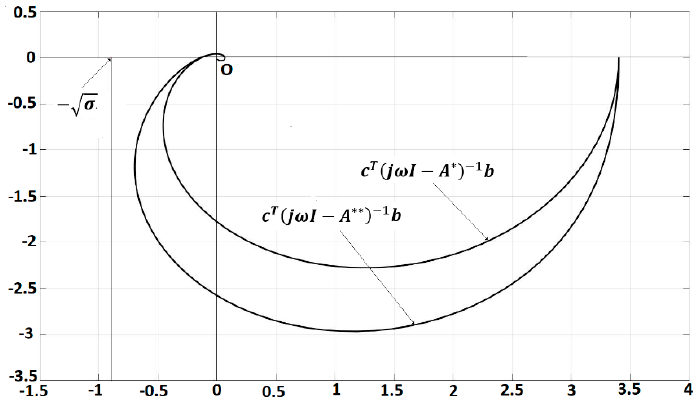
Figure 2. Exoskeleton Glove Control System.